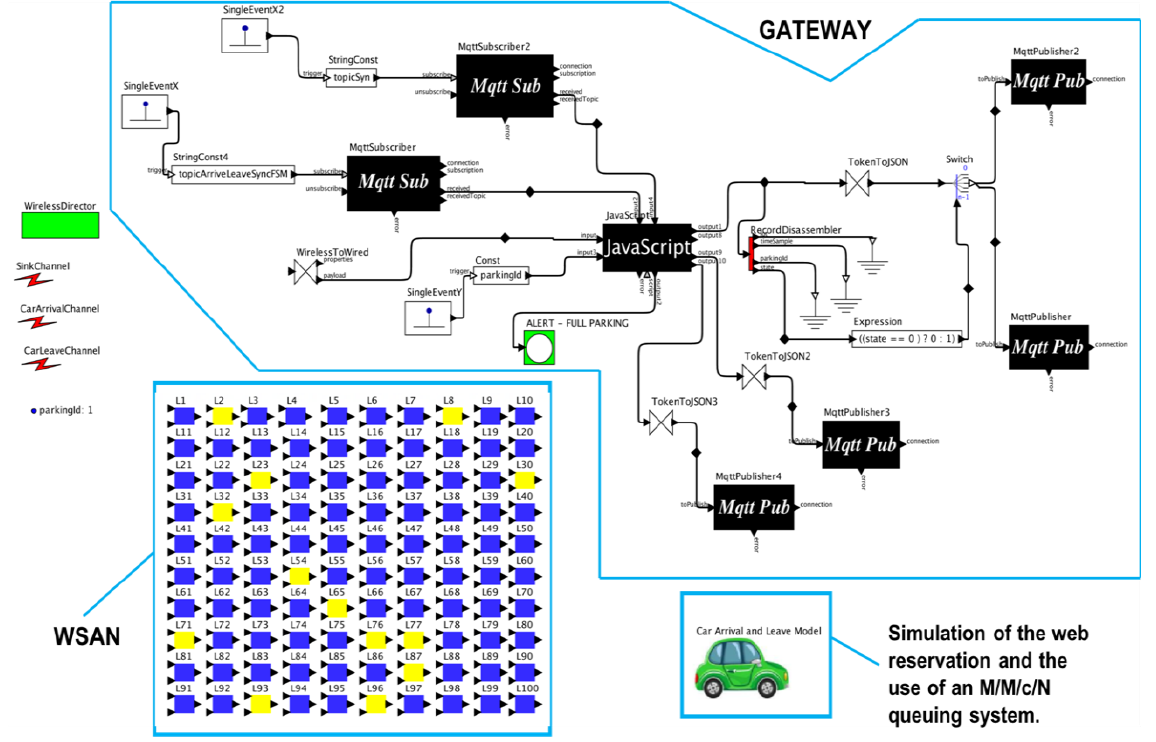
Figure 6. Parking lot model.